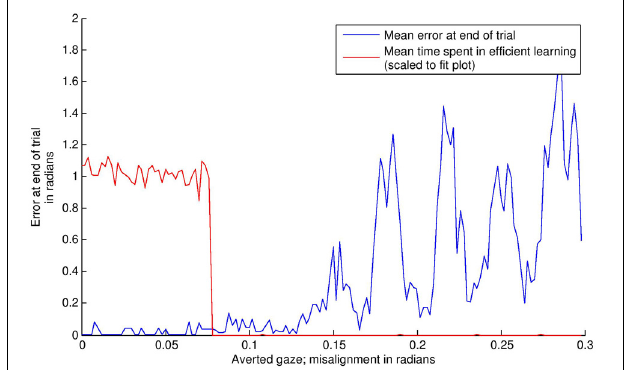
FIGURE 8 | The effects of averted gaze on attention and learning. The blue line shows mean error (over 100 trials) versus level of misalignment. The red line shows the mean amount of time spent usefully in “learning mode” (i.e., ¨ S = 1, and the subject has the stimulus in view). These latter data have been scaled to fit on the graph. Misalignments up to about 0.07 radians are mostly undetectable, and the subjects spend about half the trial on average (the expected mean amount if the subject usually finds the stimulus) in learning mode, with the stimulus in their field of vision. Over this level, there is a steep drop off in time spent learning. Over about 0.11 radians, the subject’s ability to locate the stimulus at all becomes increasingly